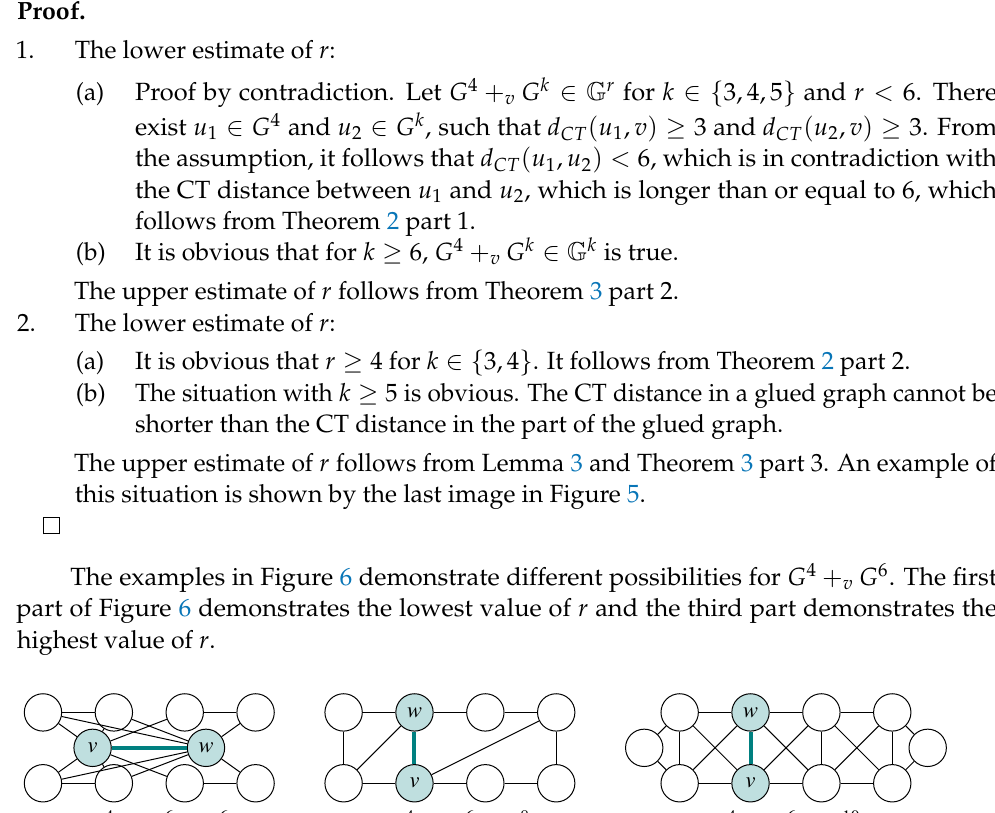
Figure 6. Gluing G 4 and G 6 via edge e = ( v , w ) . Figure 5. Gluing G 4 and G 6 via edge e = ( v , w ) .